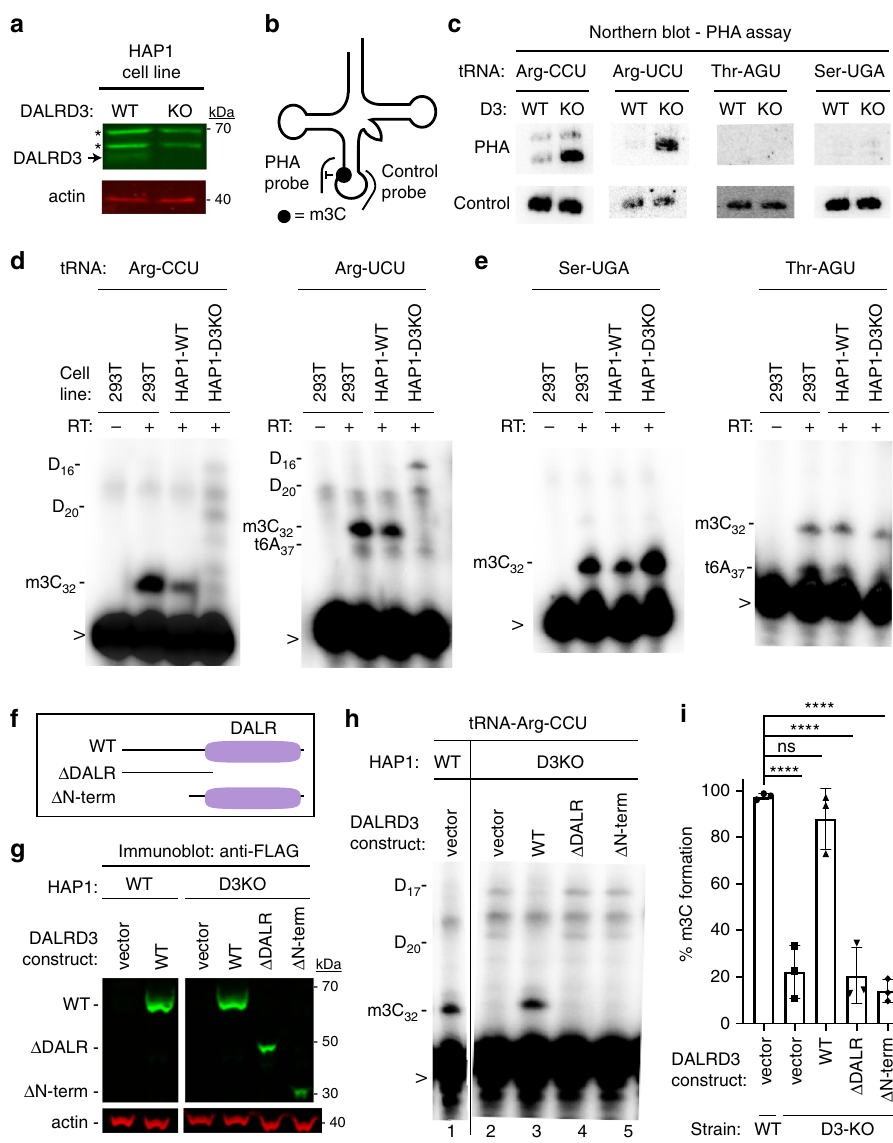
Fig. 5 DALRD3 is required for ef fi cient m3C formation in arginine tRNAs in vivo. a Immunoblot veri fi cation for the loss of DALRD3 expression in human DALRD3-knockout (KO) cell lines compared to wild-type human HAP1 cells. Actin was used as a loading control. Asterisk denotes a non-speci fi c band found in both wild-type and D3-KO cell lysates. b Schematic of the Positive Hybridization in the Absence of Modi fi cation (PHA) assay. c Northern blot analysis of PHA probes designed to detect m3C at position 32 and a control probe that hybridizes to a different area of the same tRNA. d Primer extension analysis of the tRNA-Arg-UCU and Arg-CCU harvested from the denoted human HAP1 cell lines. Length of primers; tRNA-Arg-UCU, 24 nt; tRNA-Arg- CCU, 23 nt. e Primer extension analysis of the tRNA-Ser-UGA and Thr-AGU harvested from the denoted human HAP1 cell lines. Length of primers; tRNA- Ser-UGA, 23 nt; tRNA-Thr-AGU, 20 nt. f Schematic of DALRD3 variants used for DALRD3 rescue experiments. g Immunoblot analysis con fi rming expression of DALRD3 variants in the indicated HAP1 cell lines. h Primer extension analysis of tRNA-Arg-CCU from WT or D3KO HAP1 cell lines stable integrated with the indicated DALRD3 expression constructs. (-RT) represents no reverse transcriptase was added; m3C- 3-Methylcytidine; D- dihydrouridine; t6A- threonylcarbamoyladenosine; > labelled probe. i Quanti fi cation of m3C formation in tRNA-Arg-CCU by primer extension. n = 3. Error bars represent standard deviation from the mean. Statistical analysis was performed using one-way ANOVA and signi fi cance calculated using Tukey ’ s multiple comparison test. **** P < 0.0001; ns, non-signi fi cant. P = 0.7430 for WT strain + vector versus D3-KO strain + WT-DALRD3. a , ( c through e ), g , h were repeated three times each with similar results. Source data are provided as a Source data fi